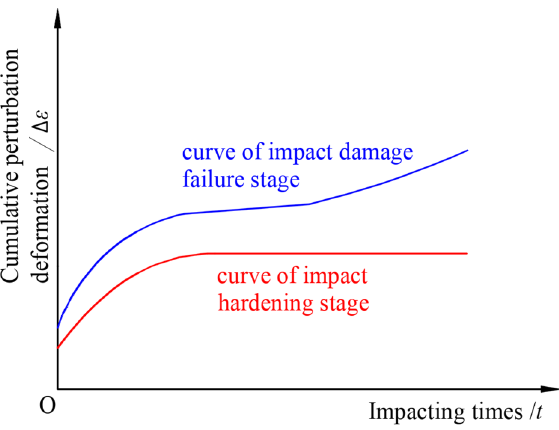
Figure 1. Curve of the rock’s cumulative perturbation